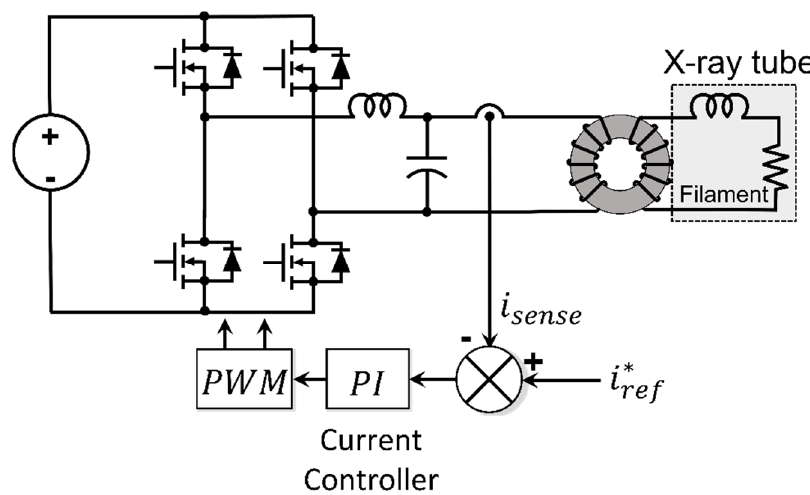
Figure 4. Conventional filament driver circuit and the control diagram.